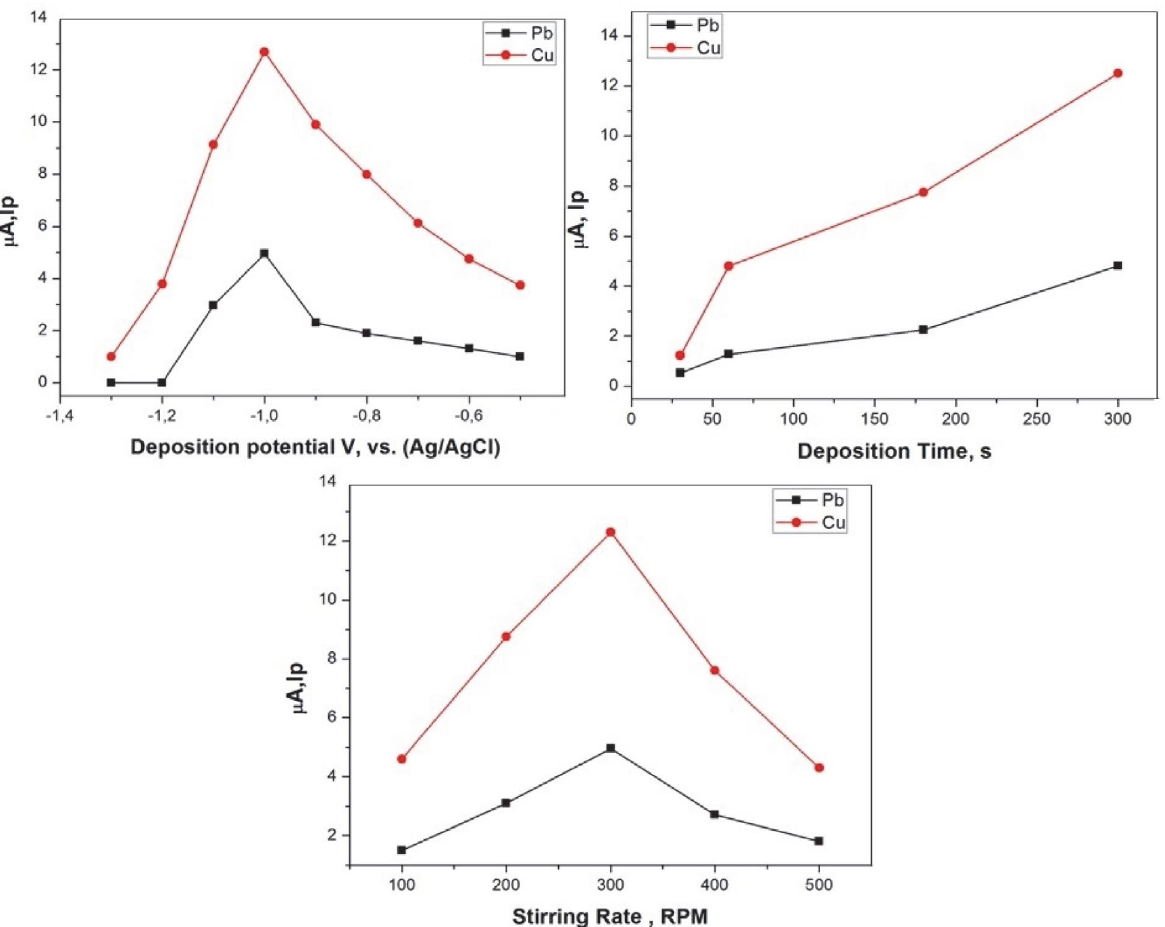
Fig. 7. Effect of deposition potential, deposition time, and stirring rate on the stripping peak current for a solution containing 0.20 mol L −1 PBS (pH = 5), 1.0 × 10 −6 mol L −1 Cu(II) and 1.0 × 10 −6 mol L −1 Pb(II); scan rate: 0.1 V s −1 .